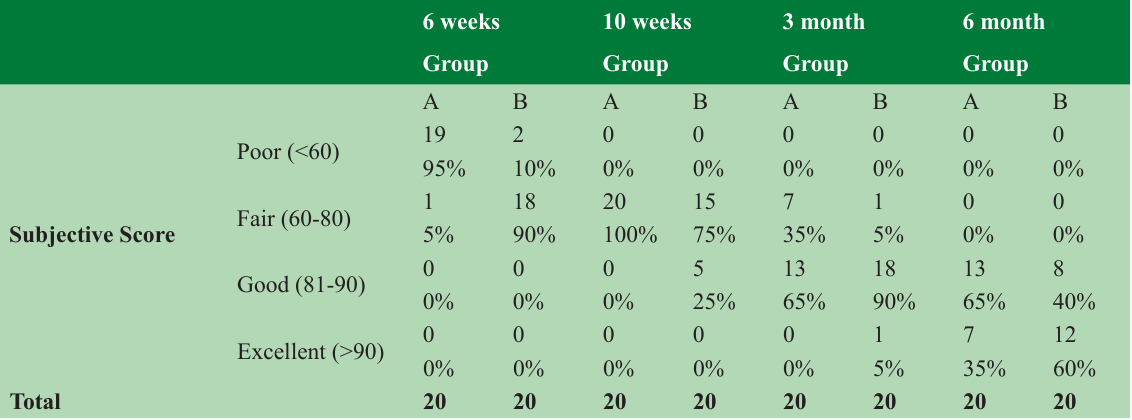
Table 1: Subjective Scores at the follow ups